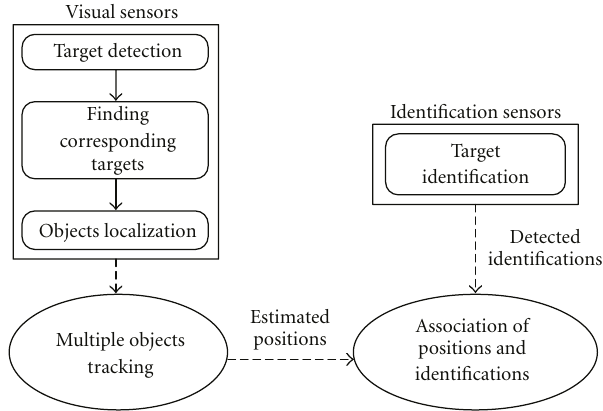
Figure 2: Illustration of the overall architecture of the proposed heterogeneous sensor system using visual sensor and identification sensor.